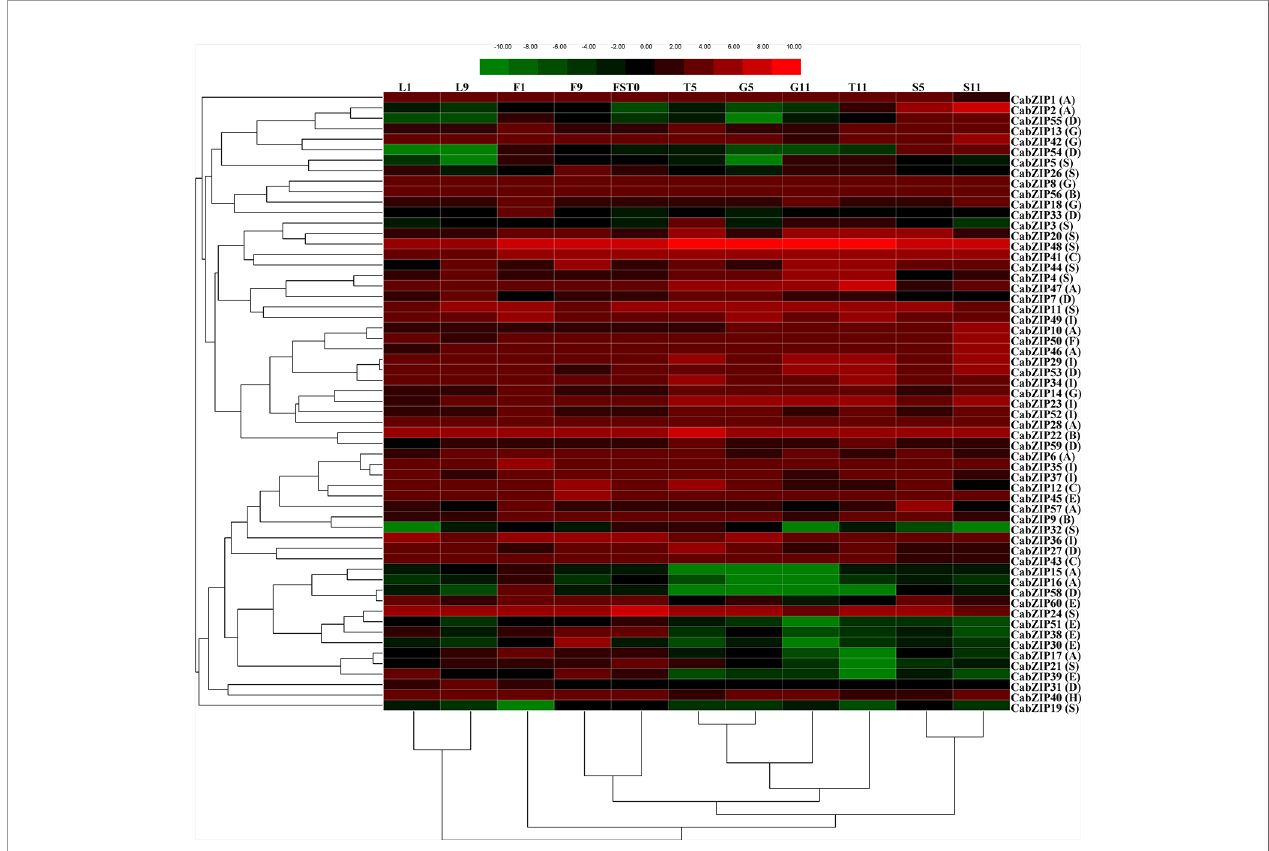
FIGURE 3 | Expression patterns of 59 CabZIP genes differentially expressed in six tissues. The image summarized the organ-speci fi c expression pro fi les of 59 CabZIPs in pepper. The expression levels are normalized using log2. The color scale representing expression values is shown at the top. Green indicates low expression values, black indicates intermediate expression values and red indicates high expression values. Genes and the tissues of different developmental stages are clustered according to their expression pro fi les. Group numbers were labeled after each gene name. The L1 and L9 denote leaf collected at 2 and 60 days after emergence, respectively. The F1 and F9 denotes fl oral bud collected at smallest and biggest size, respectively. The FST0 denotes fruit collected on 3 days after fl owering (DAF). The T5 and T11 denotes placenta collected on 30 and 60 DAF, respectively. The S5 and S11 denotes seed collected on 30 and 60 DAF, respectively. The G5 and G11 denotes pericarp collected on 30 and 60 DAF,